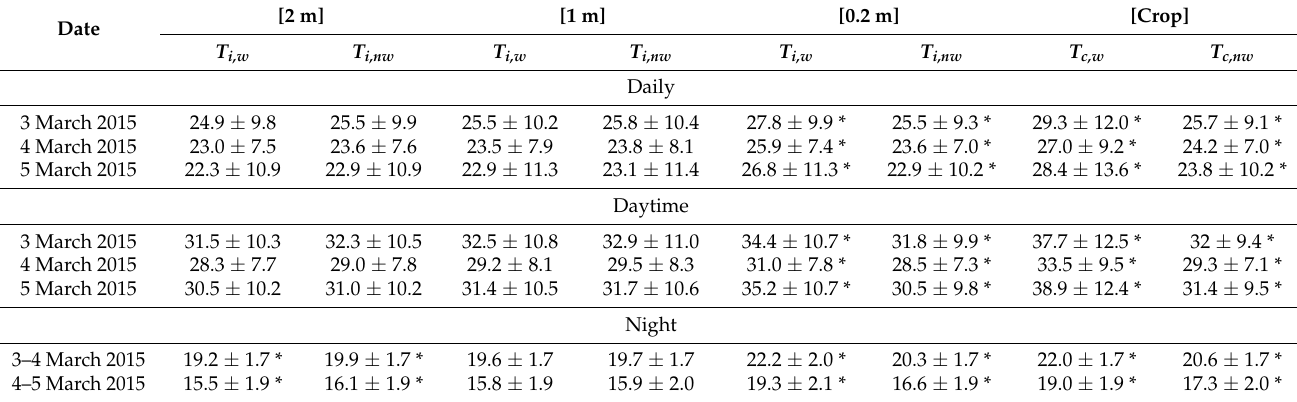
Figure 3. Temperature in the zone without low tunnel ( a ) and in the zone with low tunnel ( b ) measured from the 3 to 5 March 2015: air temperature at 2 m ( ─ ), at 1 m ( ‐‐‐ ) and at 0.2 m ( ‐∙‐ ) in height; outside air temperature ( ▬ ); plant leaves temperature ( ∙∙∙ ). Table 3. Temperatures inside the greenhouse [average value ± standard deviation]. T i , air temperature [ ◦ C]; T c , crop temperature [ ◦ C]. Subscripts: w , with low tunnel; nw , without low tunnel. Heights of air temperature measurements: two meters [2 m]; one meter [1 m] and zero point two meters [0.2]; crop temperature